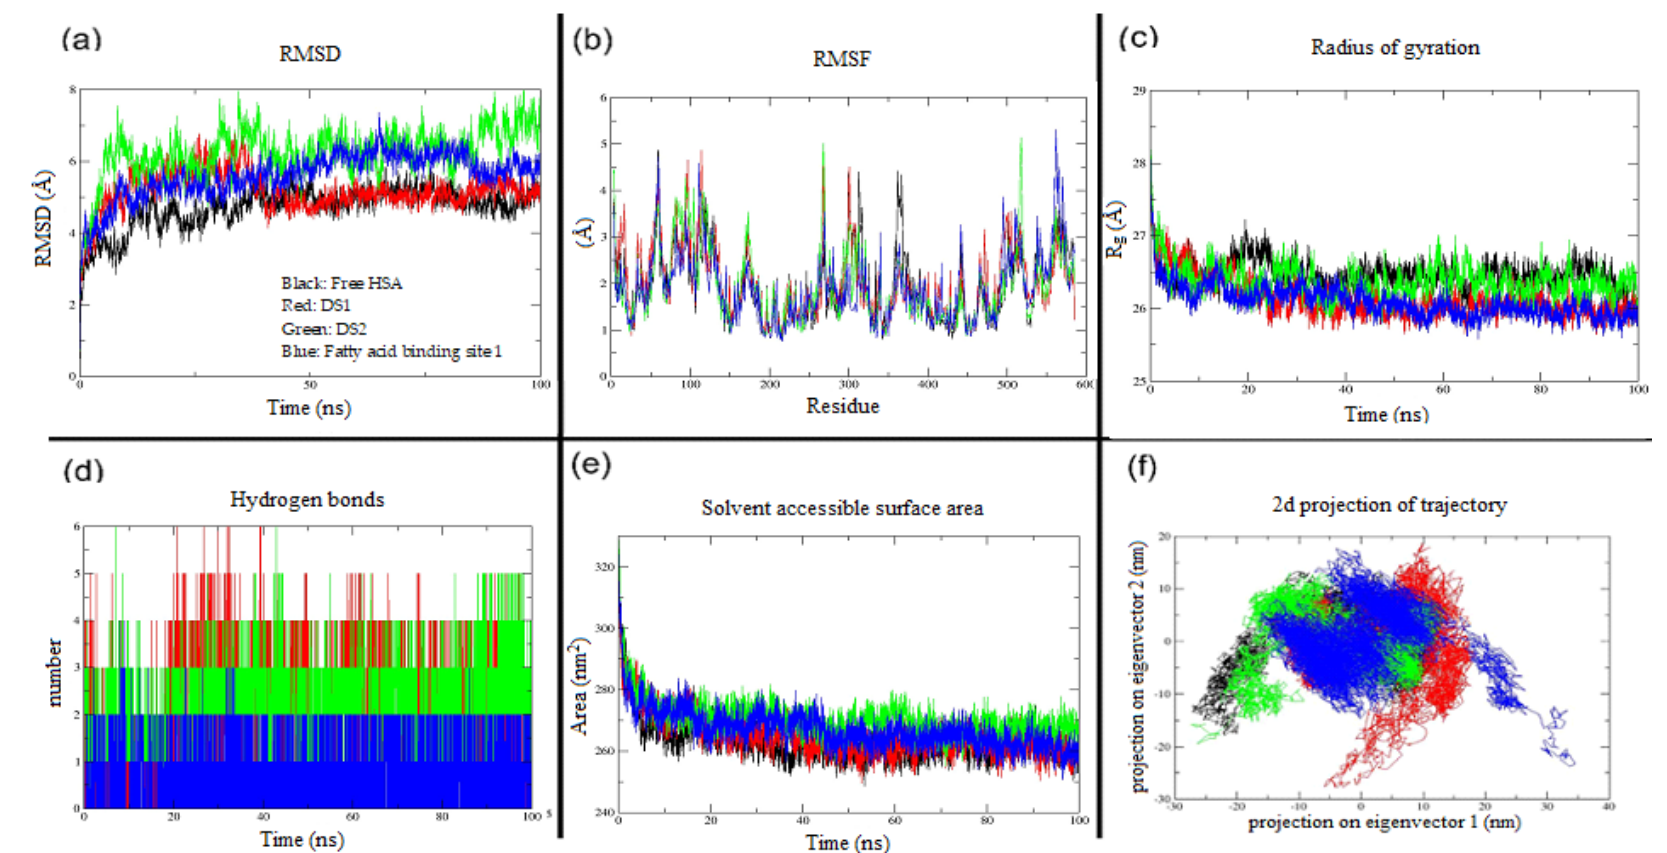
Figure 10. Molecular dynamics simulation results of free HSA and three sites of human serum albumin with indomethacin ( a ) root mean square deviation, ( b ) root mean square fluctuation, ( c ) radius of gyration, ( d ) intermolecular hydrogen bonds ( e ) solvent accessible surface area, and ( f ) essential motion using principal component analysis (color codes: black—free HSA, red—DS1, green—DS2, and blue—fatty acid binding site 1).